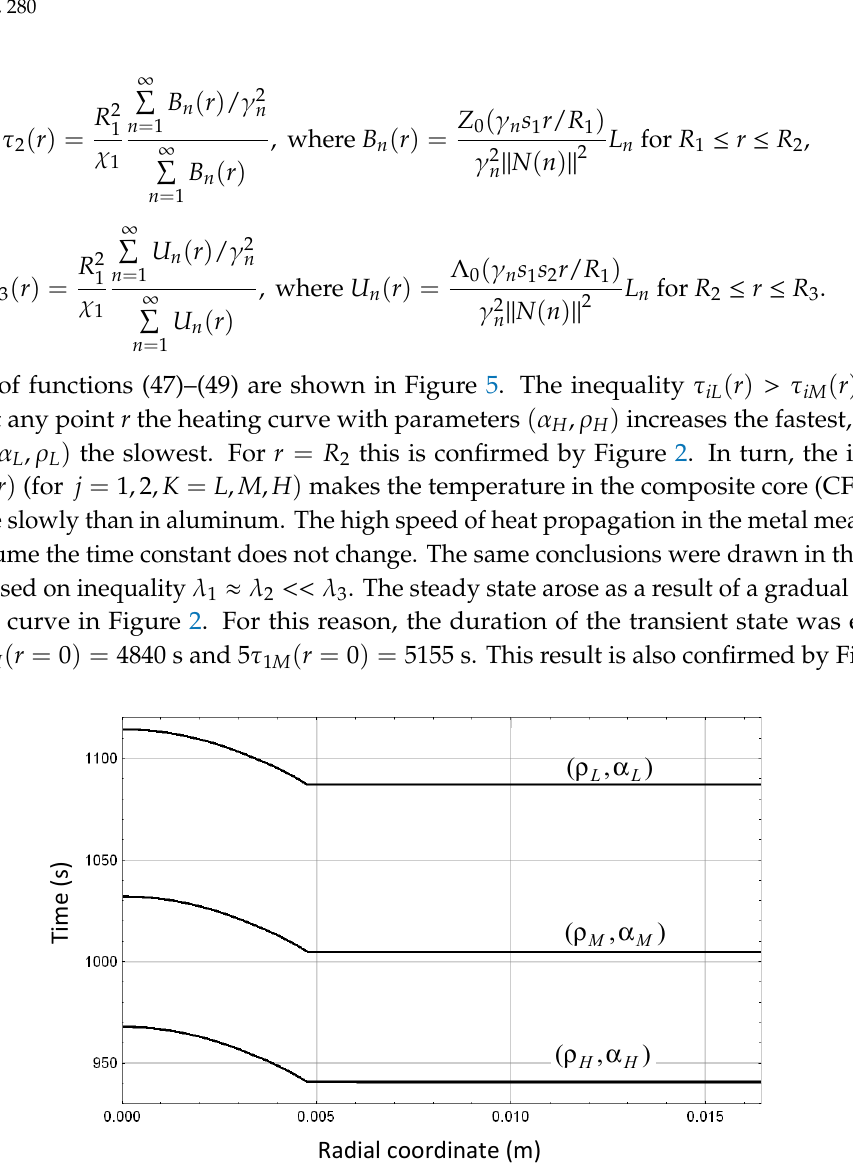
Figure 5. Distributions of local time constants with parameters ( α H , ρ H ) , ( α M , ρ M ) and ( α L , ρ L )